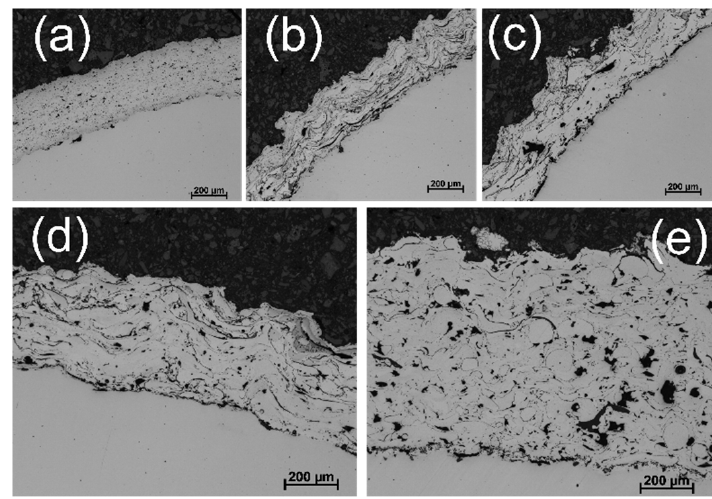
Figure 7. Optical light micrographs of the thermally sprayed coatings after 5000 h at 600 °C in model atmosphere: ( a ) HVOF Amperit 469, ( b ) TWAS 45CT, ( c ) TWAS Alloy 625, ( d ) TWAS pseudo-alloy, and ( e ) Plasma K50—16Mo3 steel base material.